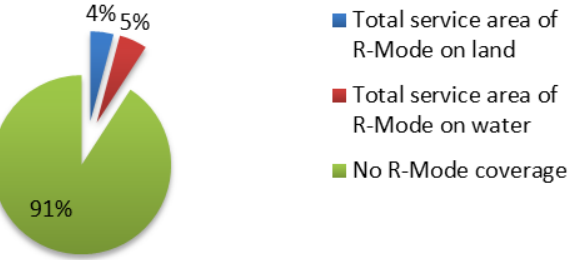
Figure 3. Distribution of the potential R-Mode service area.